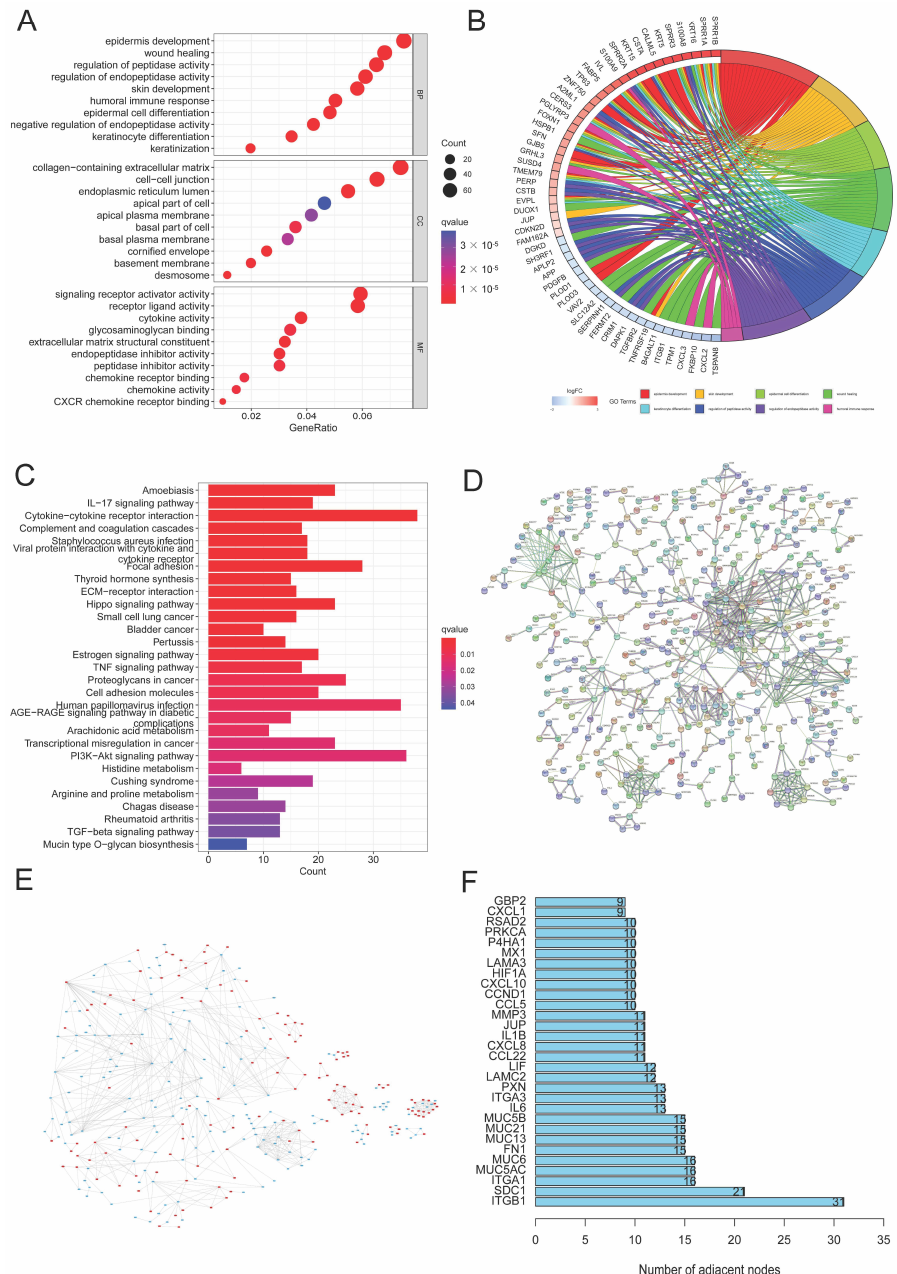
Figure 3. DEG and function assays. ( A , B ) Bubble diagram and circle plot visualizing the results of GO analysis; ( C ) KEGG analysis exploring the enriched signaling pathways; ( D ) PPI analysis of DEGs; ( E ) compared to cluster 1, the color of nodes reflects the upregulated genes (red) and downregulated genes (blue) in cluster 2; ( F ) the top 30 DEGs with the largest numbers of nodes were chosen through PPI analysis.